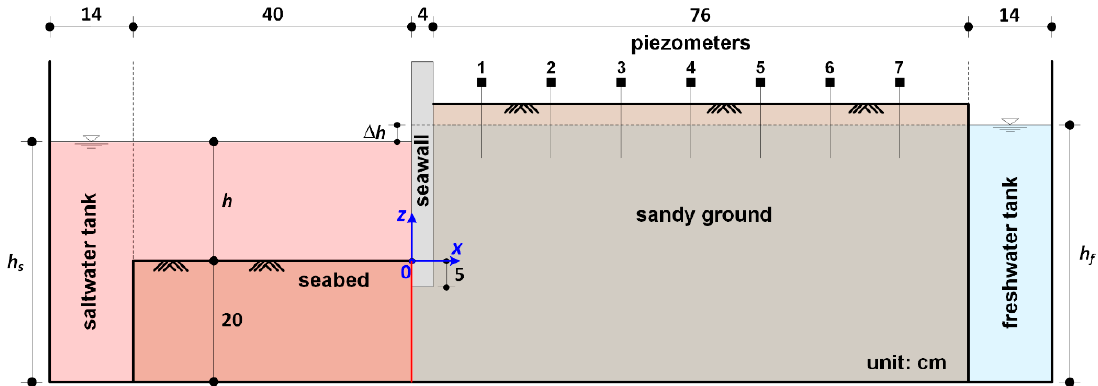
Figure 1. Schematic diagram of the sandy tank with a seawall.